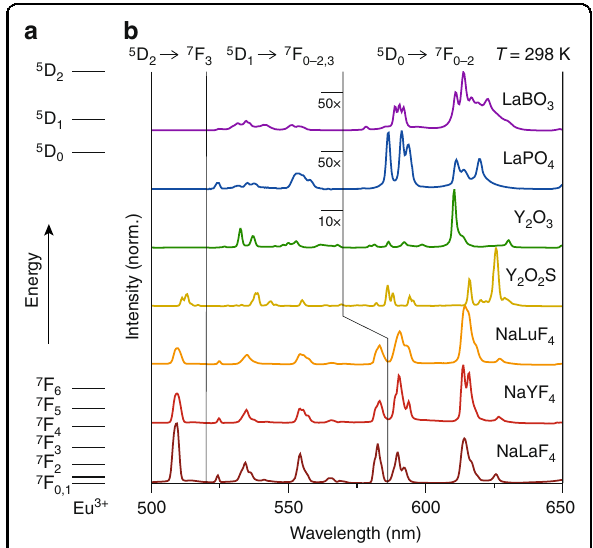
Fig. 1 Eu 3 + luminescence. a Energy level diagram of Eu 3 + . b Emission spectra of various Eu 3 + -doped host lattices acquired at room temperature. The luminescence of β -Na RE F 4 :Eu 3 + ( RE = La, Y, Lu) was excited at 395 nm into the 5 L 6 level, while Eu 3 + in the other samples was excited into the ligand-to-metal charge-transfer band at 250 – 310 nm. To prevent cross-relaxation low Eu 3 + concentrations of 0.4 – 0.5% were used in LaBO 3 , LaPO 4 , NaLuF 4 , NaYF 4 , and NaLaF 4 , while this required even lower dopant concentrations of 0.1% and 0.05% for Y 2 O 2 S and Y 2 O 3 , respectively. The vertical lines mark the wavelength range of the 5 D 1 ! 7 F 0 – 3 emissions of β -Na RE F 4 :Eu 3 + and the 5 D 1 ! 7 F 0 – 2 emissions of the other materials. The emissions were magni by a factor 10 for Y 2 O 3 and by a factor of 50 for LaBO 3 and LaPO